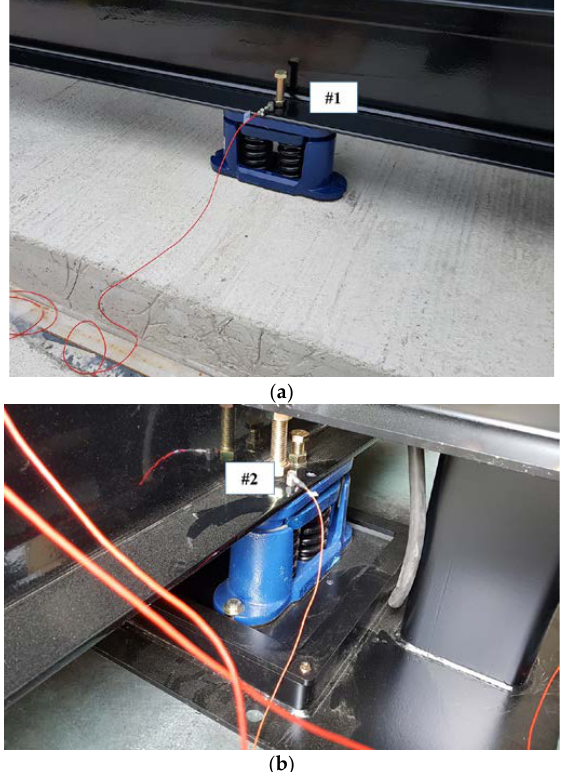
Figure 8. Configuration of attached sensor locations at electric power plant: ( a ) current mount (#1) and ( b ) proposed mount (#2). ( b ) proposed mount